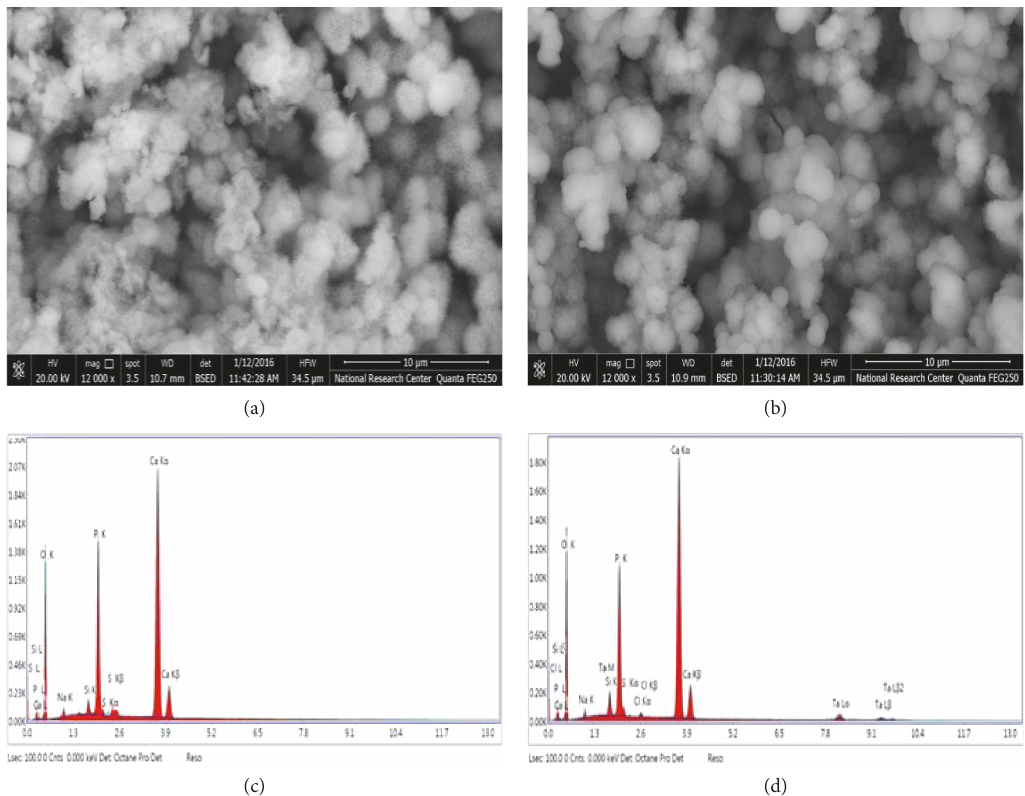
Figure 4: SEM micrographs of hydrated MTA Angelus (a) and NeoMTA Plus (c) after being immersed in PBS for 15 days as well as EDX analysis of hydrated MTA Angelus (c) and NeoMTA Plus (d) after being immersed in PBS for 15